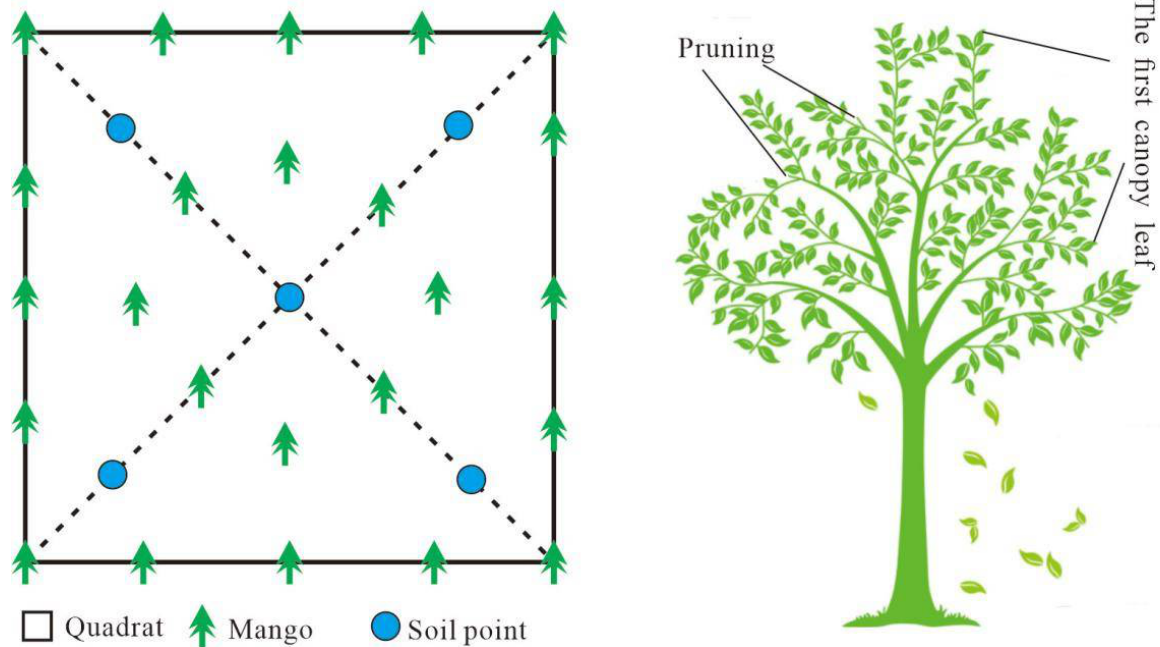
Figure 2. Schematic diagram of the soil and leaf sampling.